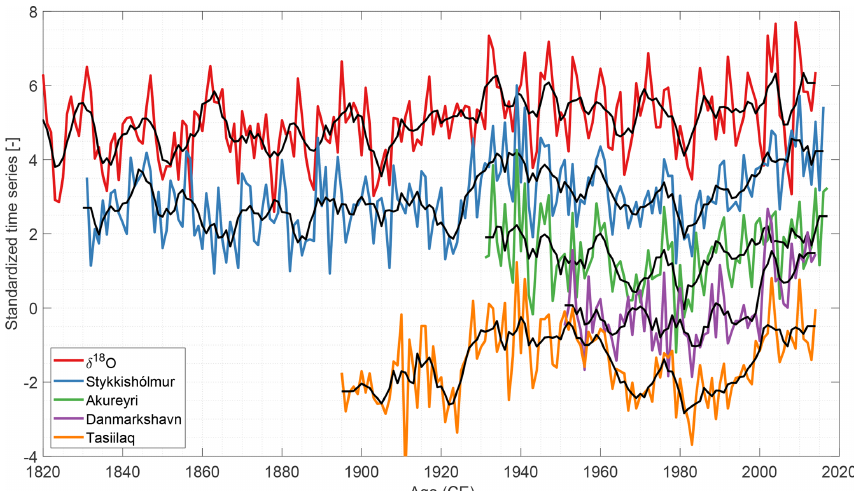
Figure C3. Summer-averaged δ 18 O and temperature series. For vi- sualization, the time series have been standardized and shifted ver- tically. The black curves represent a moving average of 5 years.